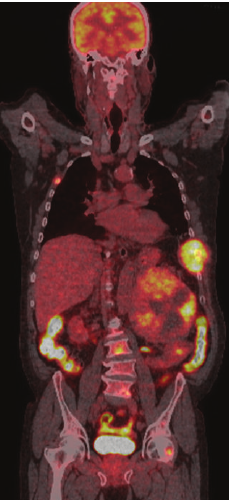
Figure 3: 127 × 143 × 144mm (RL × AP × KK) mass in the left adrenal with SUV max: 12.7 and widespread involvement of the skeletal system (multiple ribs, sacrum, sacroiliac area, and left femur).